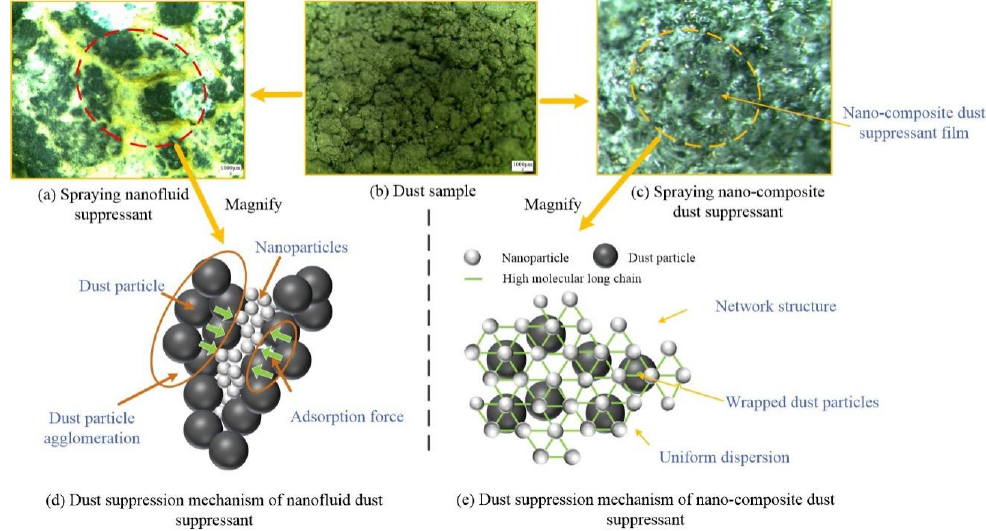
Figure 9. Suppression mechanism of nano-composite dust suppressant.